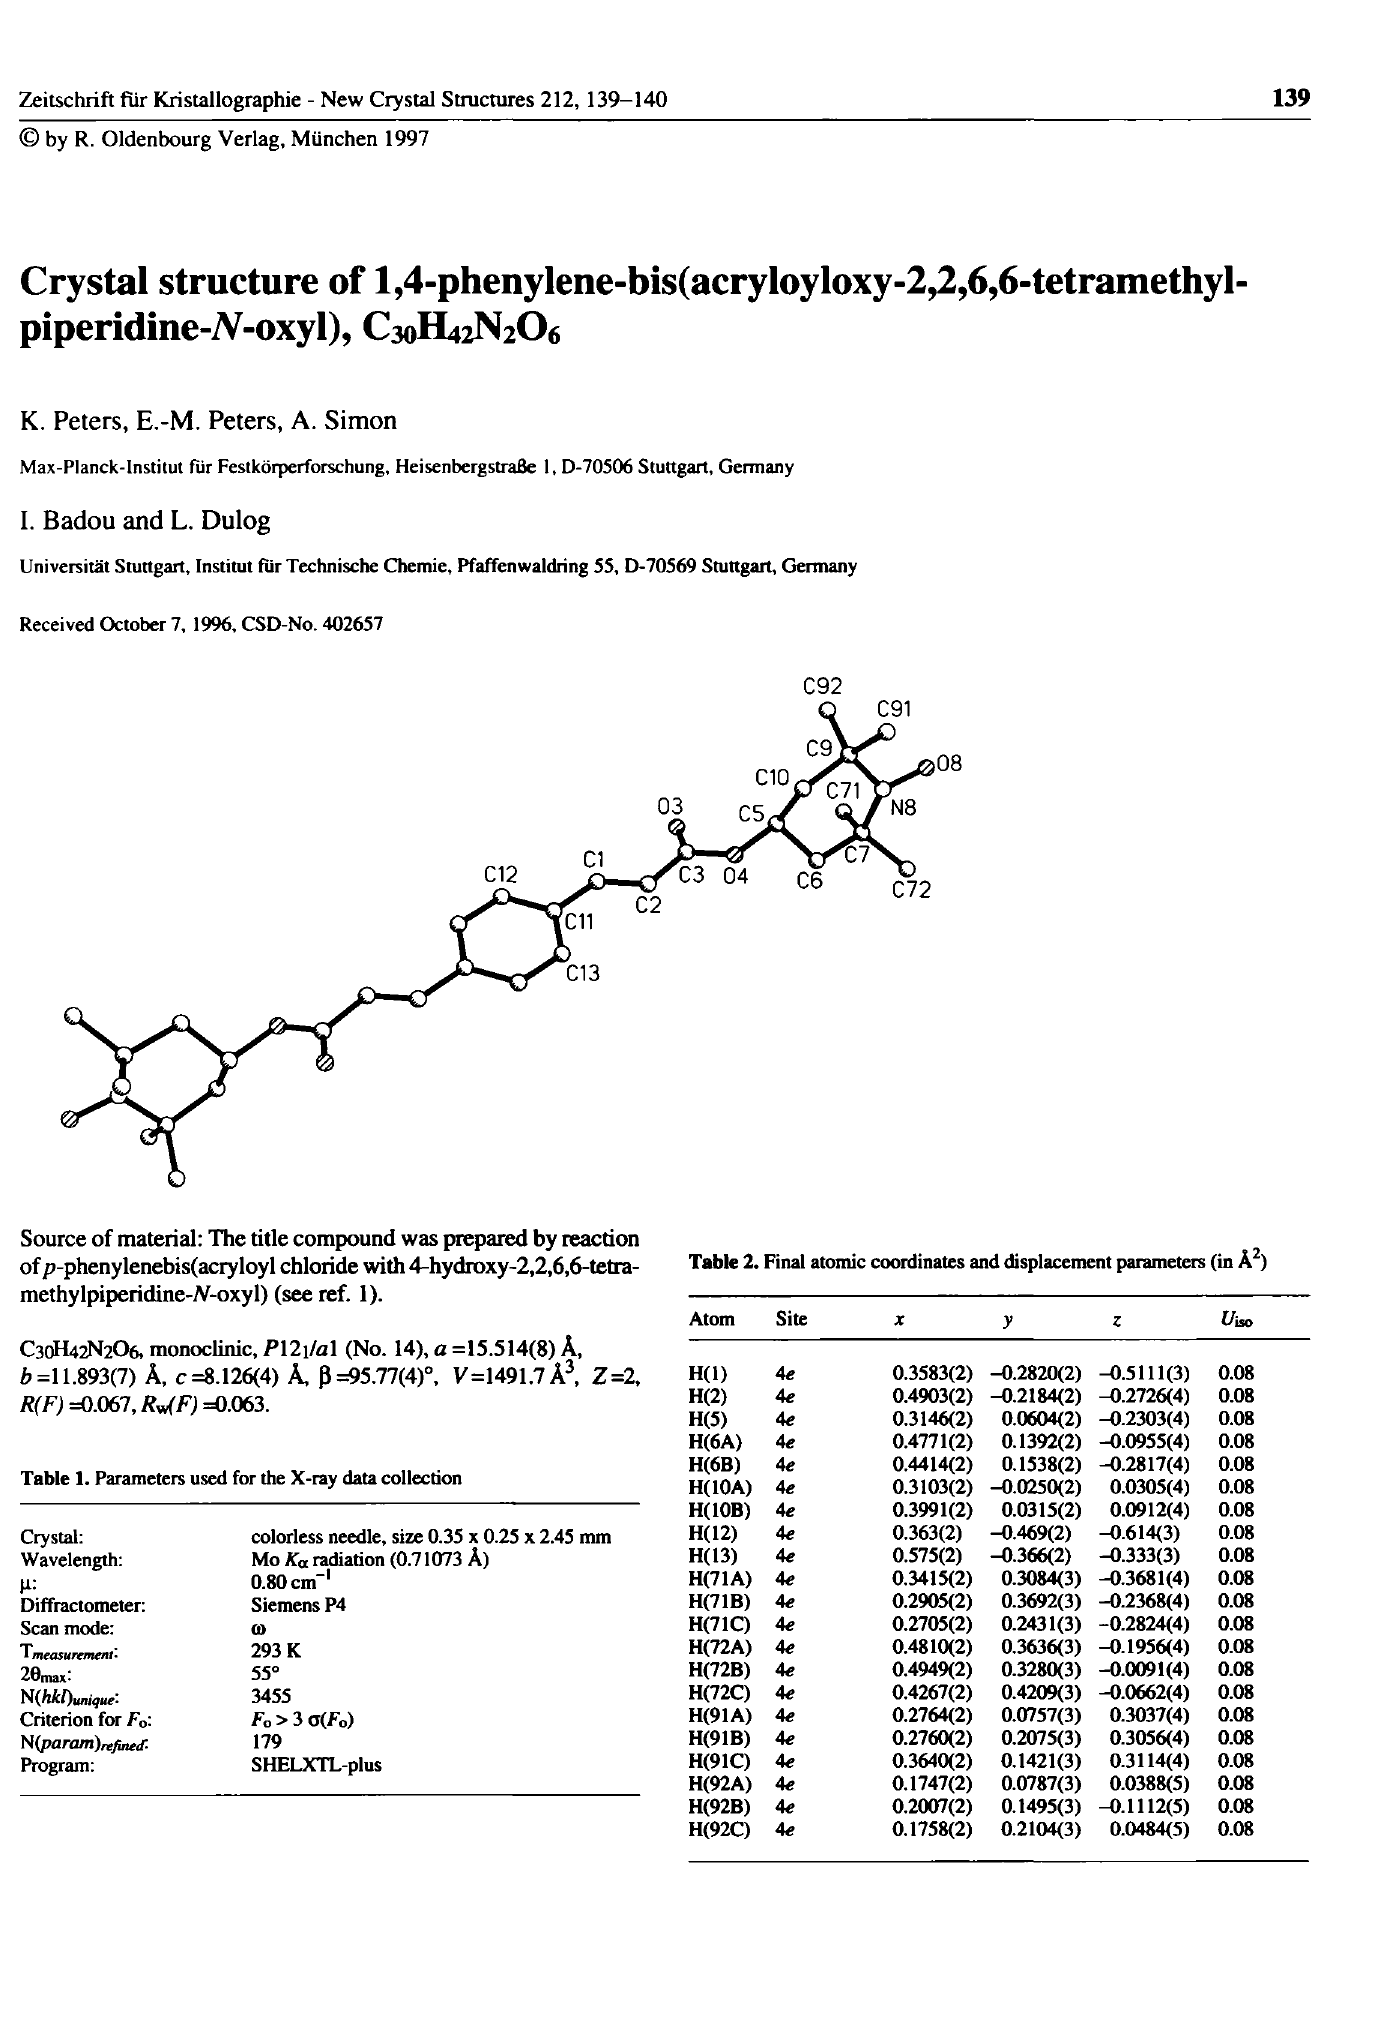
Table 2. Final atomic coordinates and displacement parameters (in Â 2